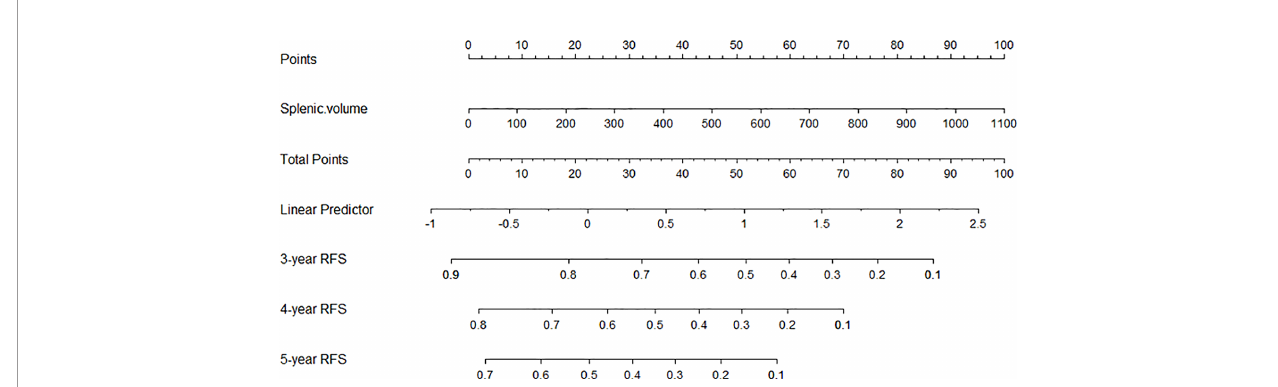
FIGURE 6 | The nomogram was developed based on SV. An individual SV value is drawn upward to determine points. Because there is only one variable, the points are the total points, and a line is drawn downward to the likelihood of 3-year RFS, 4-year RFS, and 5-year